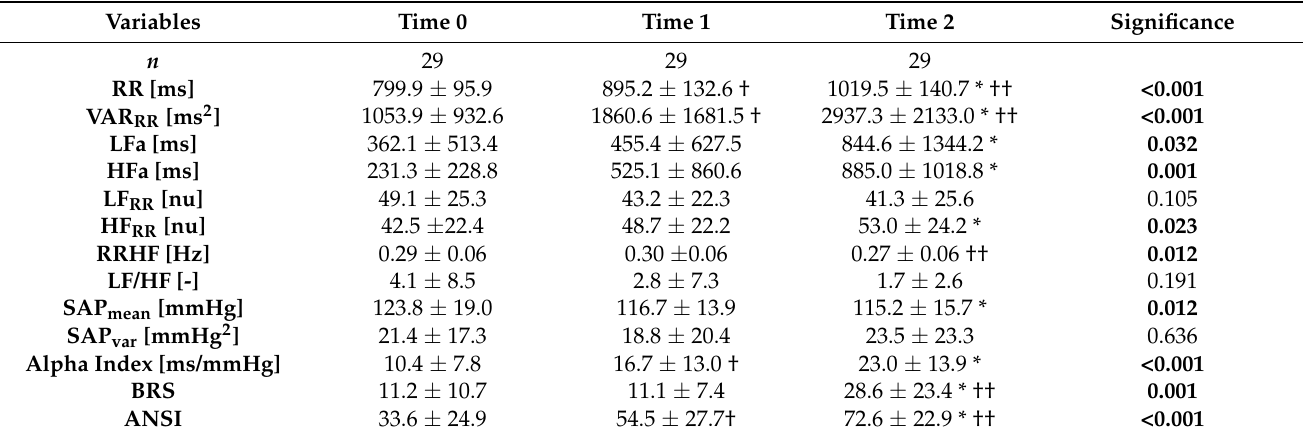
Table 3. Representative descriptive indices of RR interval and arterial pressure variability at the three study